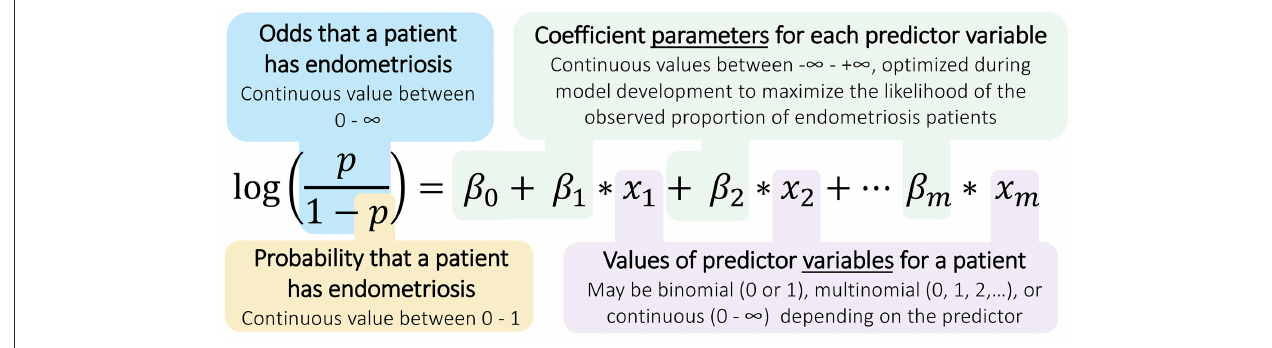
Comparing Modeling Approaches (Scope,